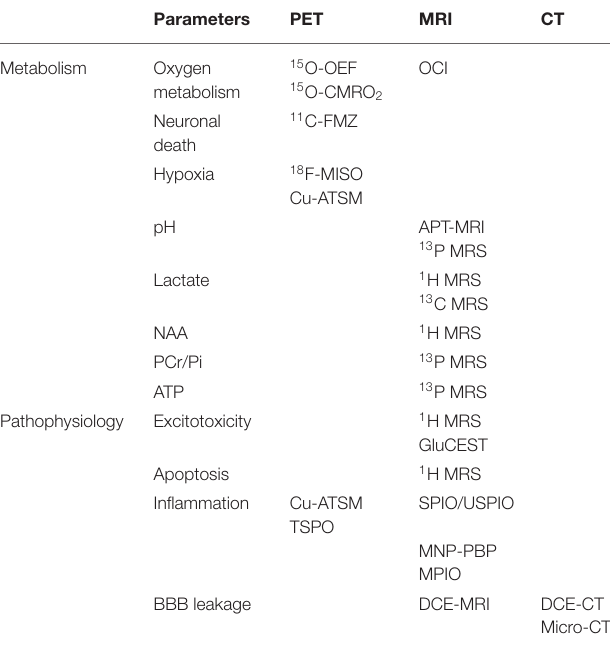
TABLE 3 | The three major imaging methods for acute stroke and physiological parameters they can detect.